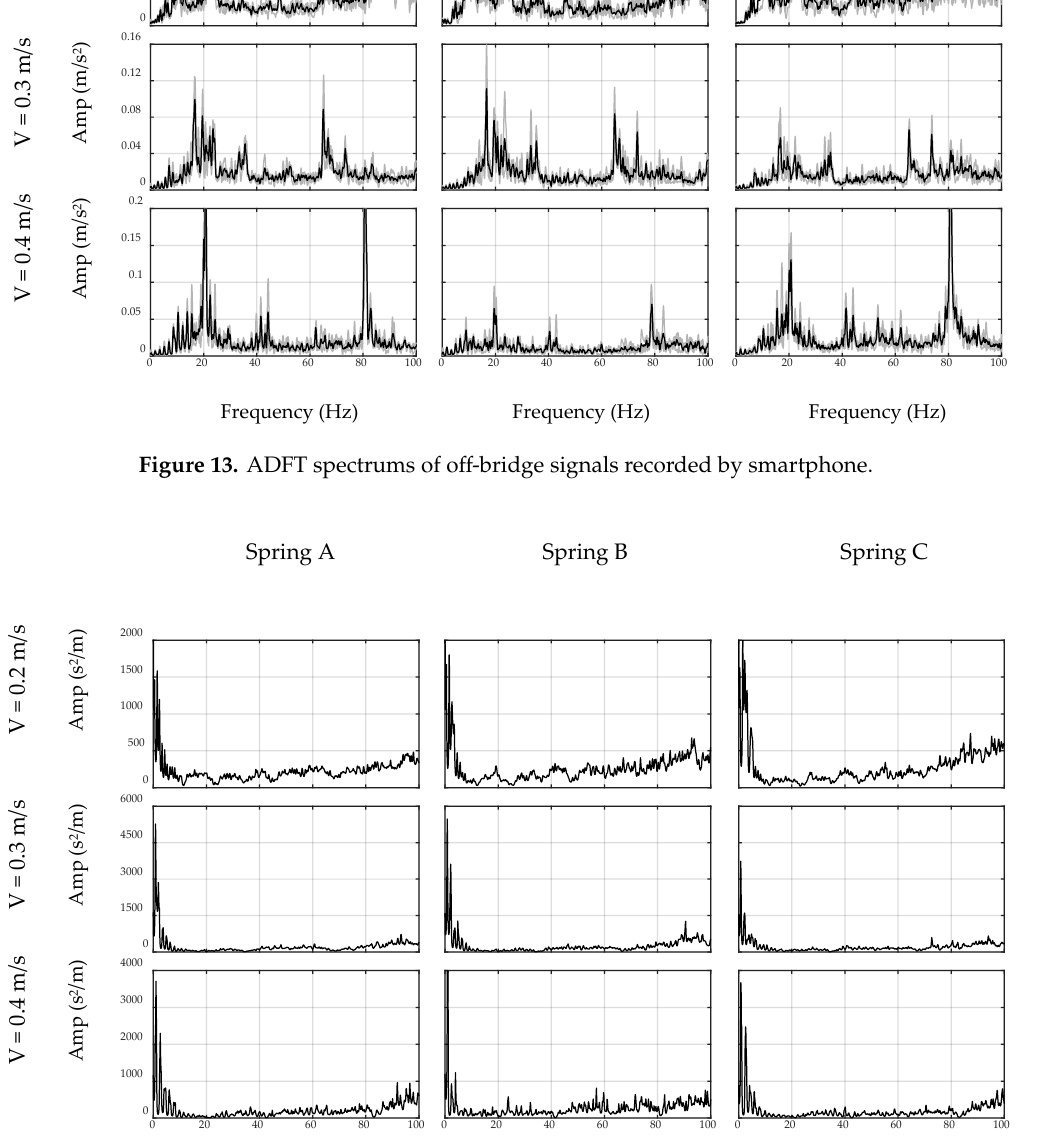
Figure 14. Inverse filter prototype based on collected signals by sensor.